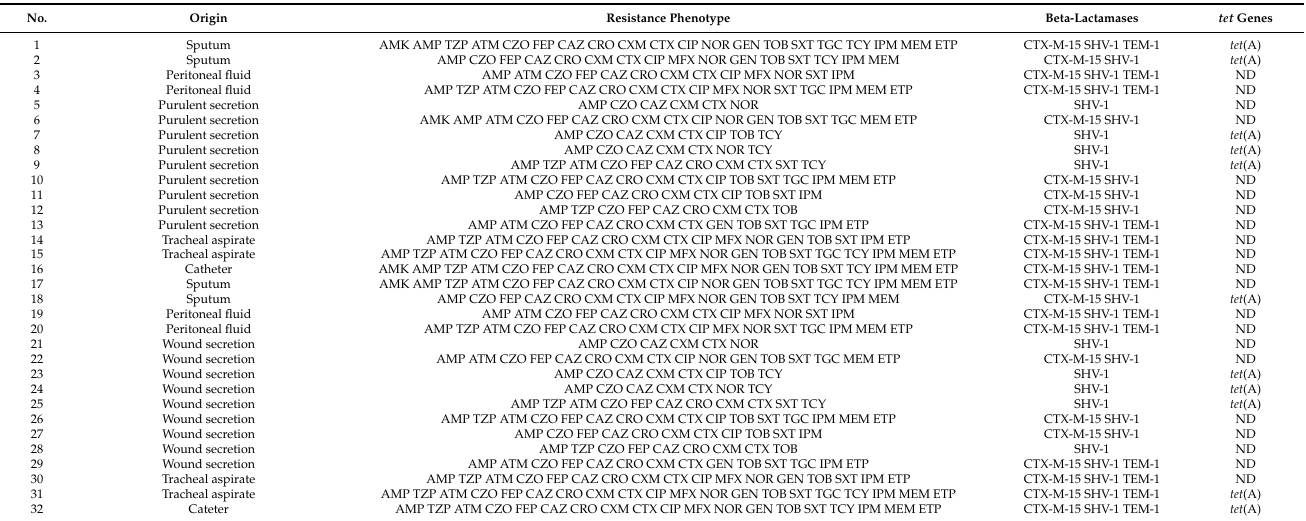
Table 2. Resistance phenotype and associated genotype in the 32 K. pneumoniae strains from clinical samples in a Romanian